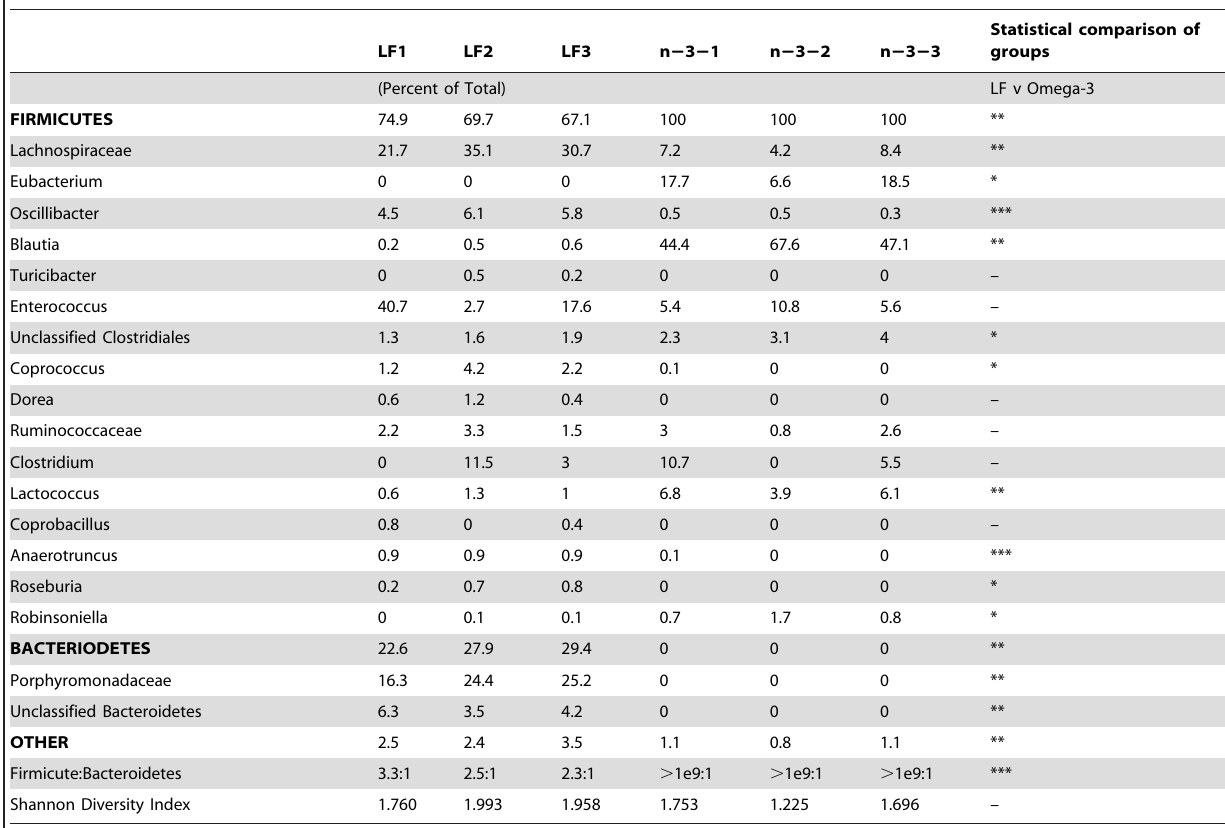
Table 2. n 2 3 pups had altered microbiomes.